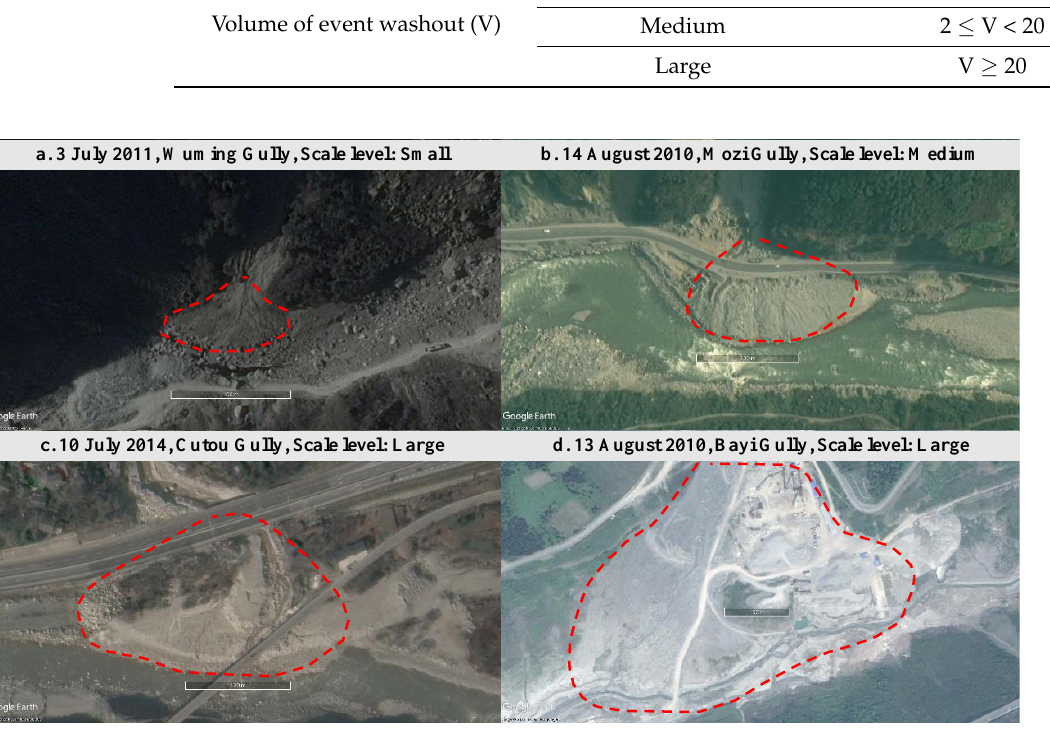
Figure 2. Comparison of images of debris flow events of different scale levels. ( a – d ) Images of debris flow events ranging from small to large (the red dashed line is the extent of debris accumulation from the debris flow event, and the white line segments are all 100 m in